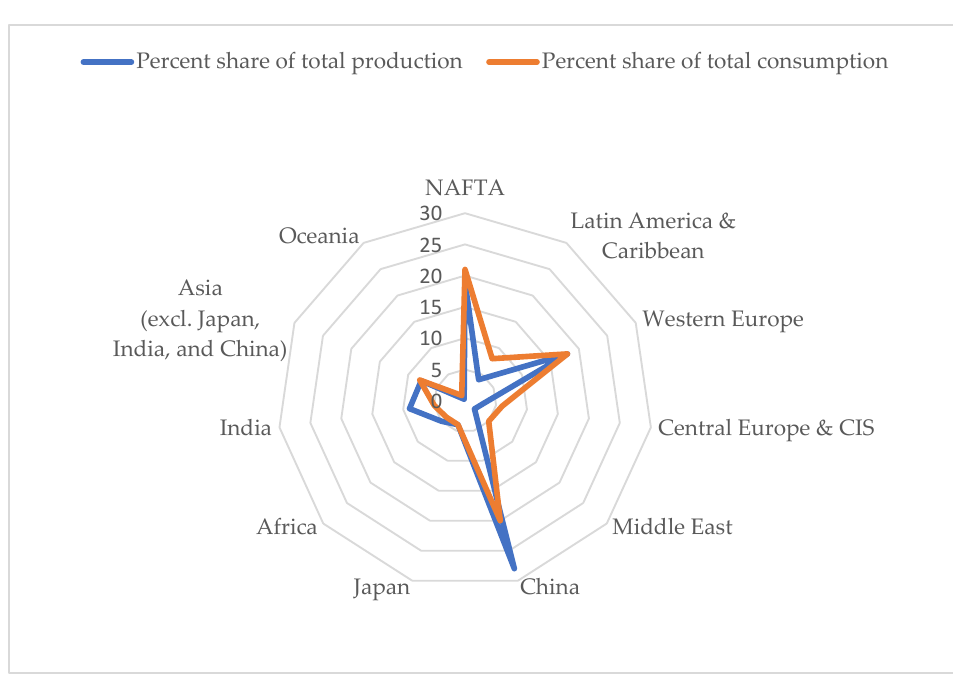
Figure 1. Regional disparities in microplastics consumption and production.